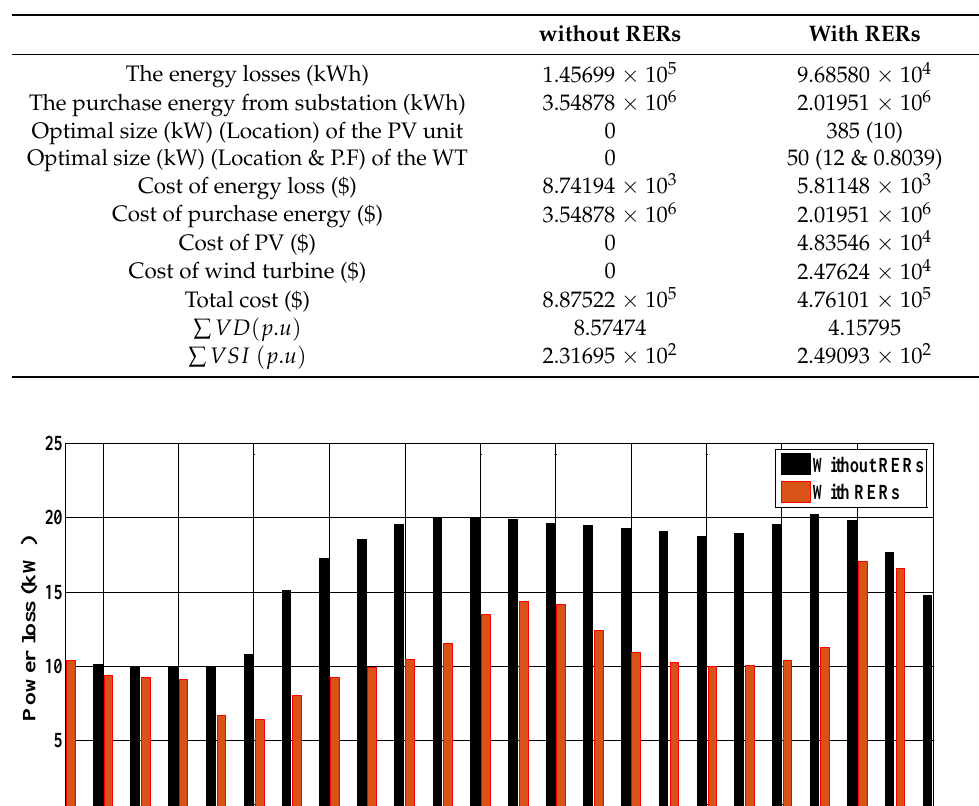
Table 5. The simulation results of energy management of the MG under probabilistic conditions.